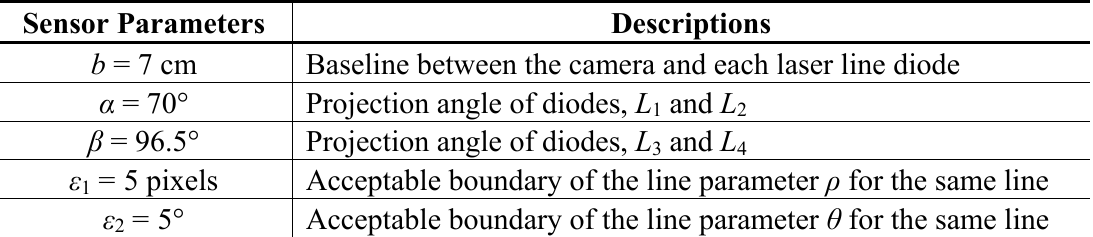
Table 2. Sensor parameters used for